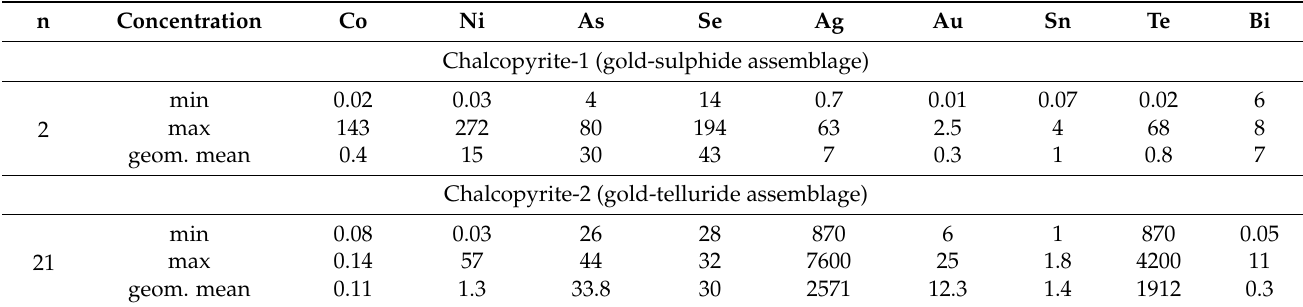
Table 10. The limits and average values of the contents of trace elements (ppm) in chalcopyrite of different assemblages of the Petropavlovsk gold-porphyry deposit according to LA-ICPMS data. n Concentration